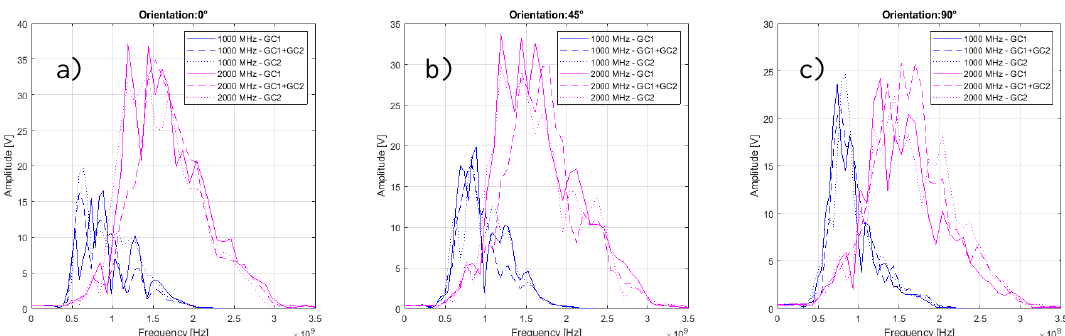
Figure 8. Frequency-domain EM response collected using the 1000 MHz (blue) and 2000 MHz (magenta) antennas with ( a ) 0°, ( b ) 45° and ( c ) 90° orientations, of sound (solid line), semi-crushed (dashed line) and totally-crushed (dotted line) dry ballast.